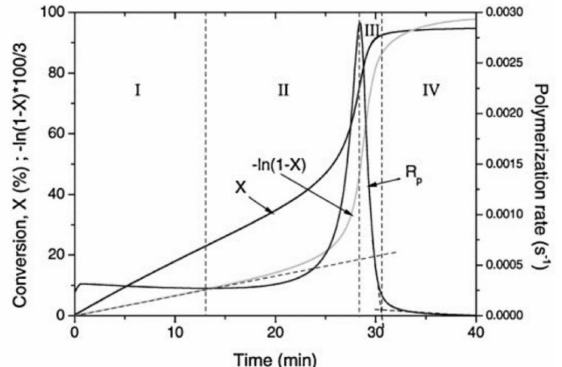
Figure 16. Indicative time evolution of the free-radical photopolymerization reaction (polymeriza- tion rate R p , conversion X and − ln ( 1 − X ) versus time) presenting the classification of the reaction into four regimes from polymerization of methyl methacrylate (MMA) at 80 ◦ C with AIBN (azo- bisisbutyronitrile) 0.03 mol L − 1 . Reprinted from reference [84] with the permission of John Wiley and